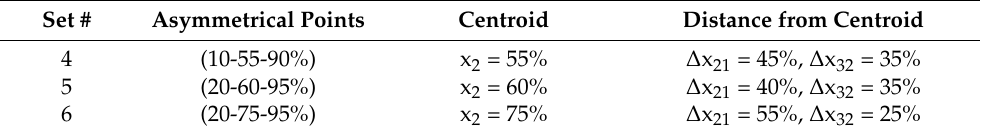
Table 6. Sets of asymmetrical points that have been